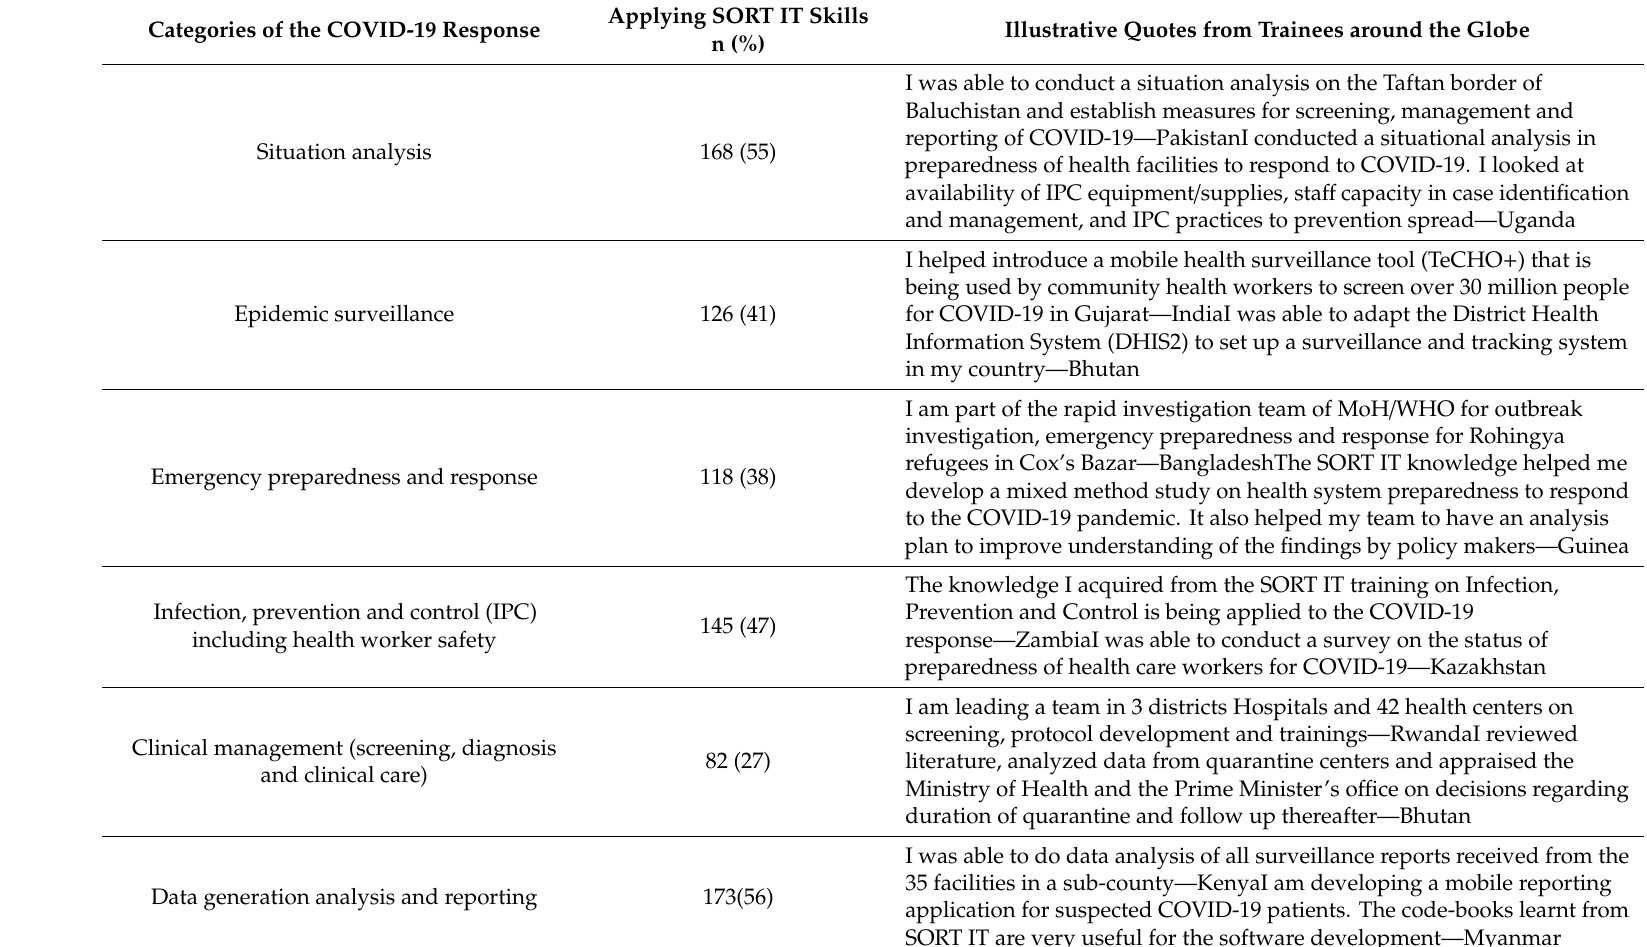
Table 1. Categories of the COVID-19 pandemic response where trainees applied skills gained through the Structured Operational Research and Training InitiaTive (SORT IT, 2009–2019). Illustrative quotes are provided for each category